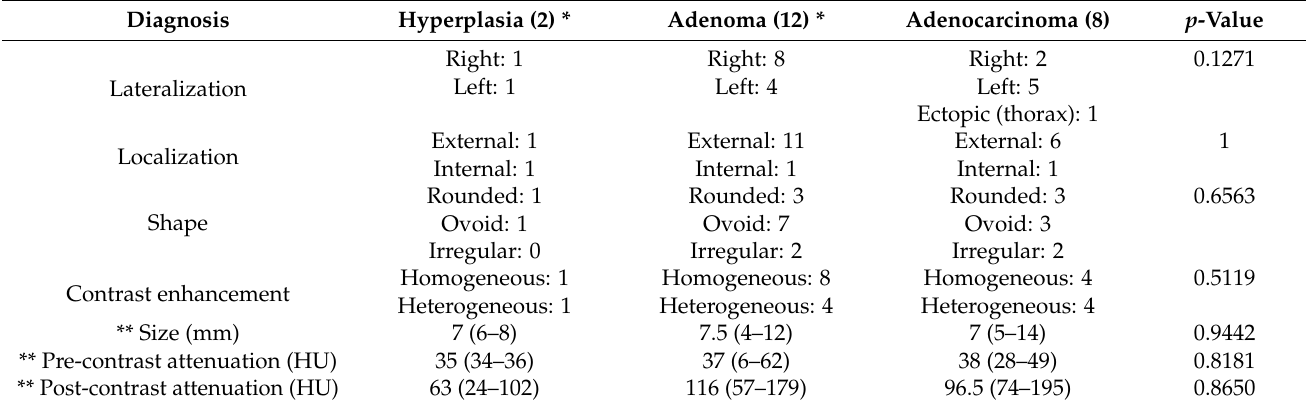
Table 1. CT features of different parathyroid diseases.